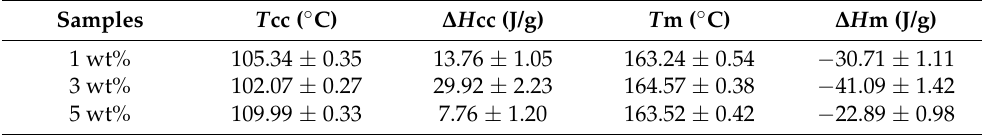
Table 1. DSC data of melt crystallization of TPU/PLA composites with different compatibilizer contents.